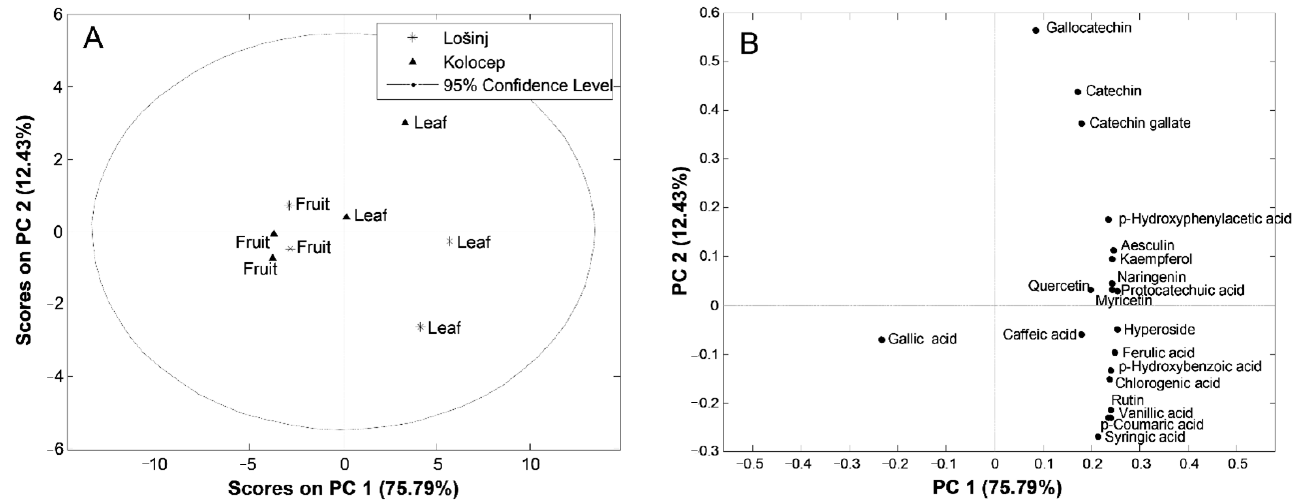
Figure 2. Principal component analysis (PCA): ( A ) score plot and ( B ) loading plot of the samples of Arbutus unedo leaves and